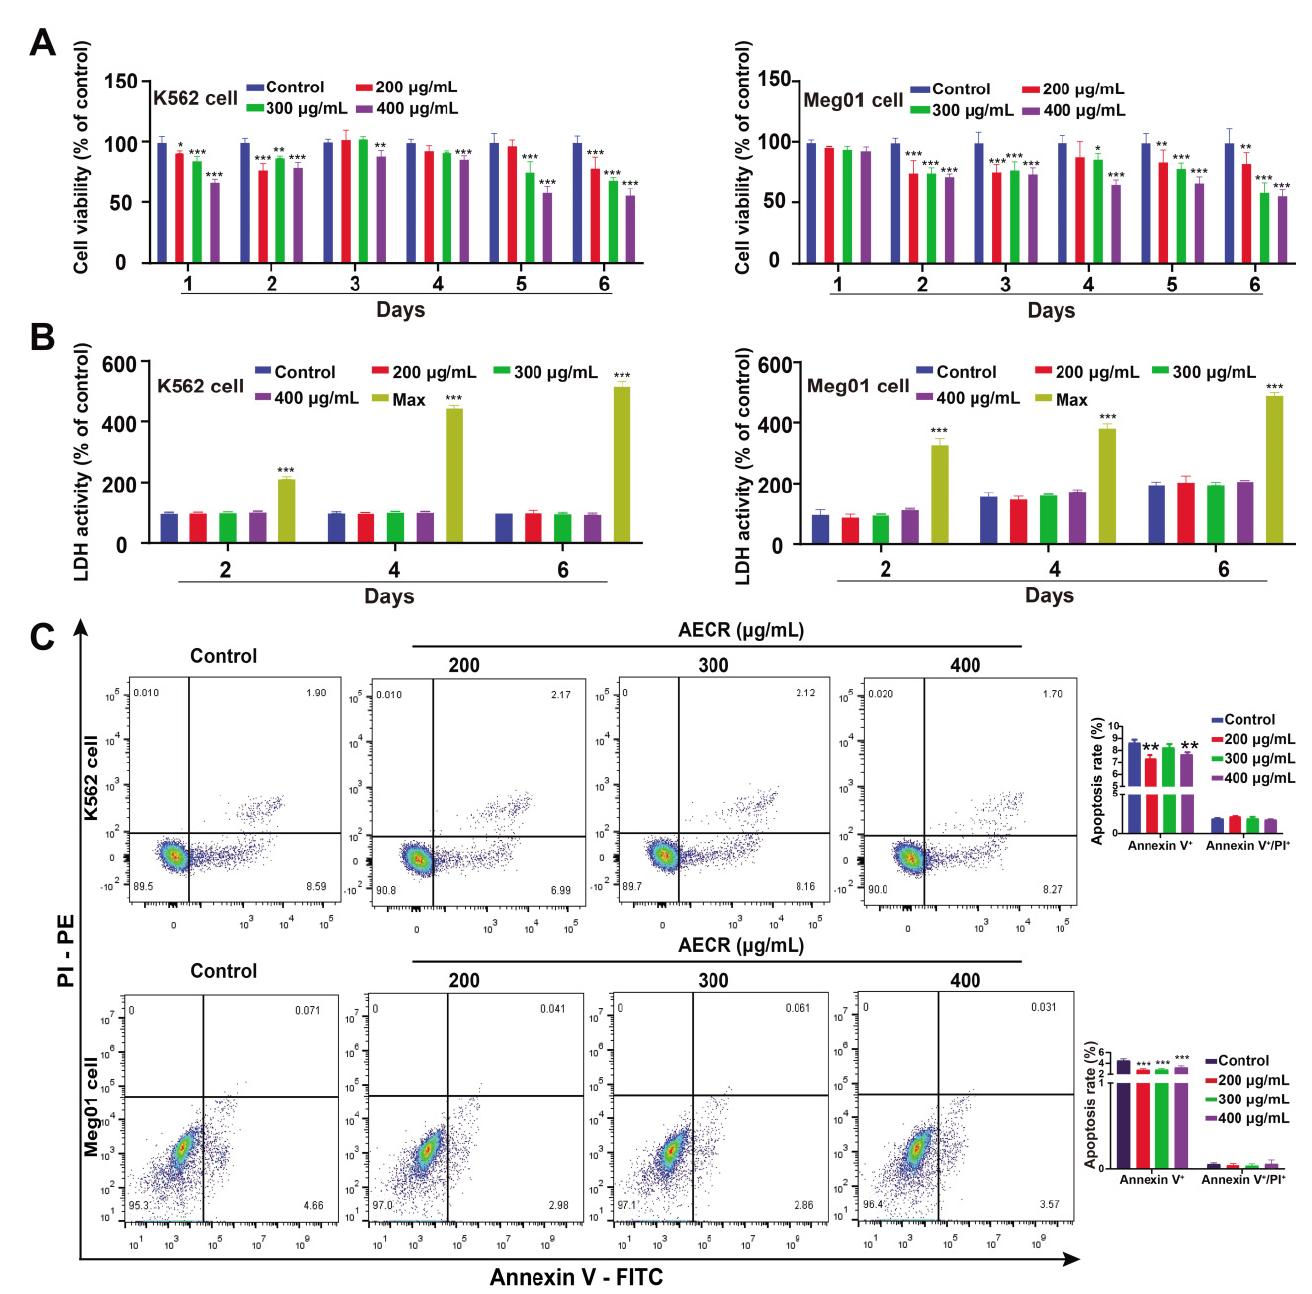
Figure 2. Determination of K562 and Meg01 cell concentrations. ( A ) Measurement of cell proliferation of K562 and Meg01 cells with the CCK-8 assay after AECR intervention. The values represent the means ± standard deviations (n = 3). ( B ) LDH assay for K562 and Meg01 cell cytotoxicity. Groups were set as follows: the control group, the AECR (200, 300, 400 µ g/mL) group, and the max group (sample maximum activity control group). Additionally, 2, 4, and 6 represent the number of consecutive days of AECR intervention. The values represent the means ± standard deviations (n = 3). ( C ) After Annexin V-FITC/PI staining for K562 and Meg01 cells, the apoptosis was detected. The values represent the means ± standard deviations (n = 3). * p < 0.05, ** p < 0.01, *** p < 0.001 versus the control group. AECRs: aqueous extracts of Cibotii rhizoma ; LDH: lactate